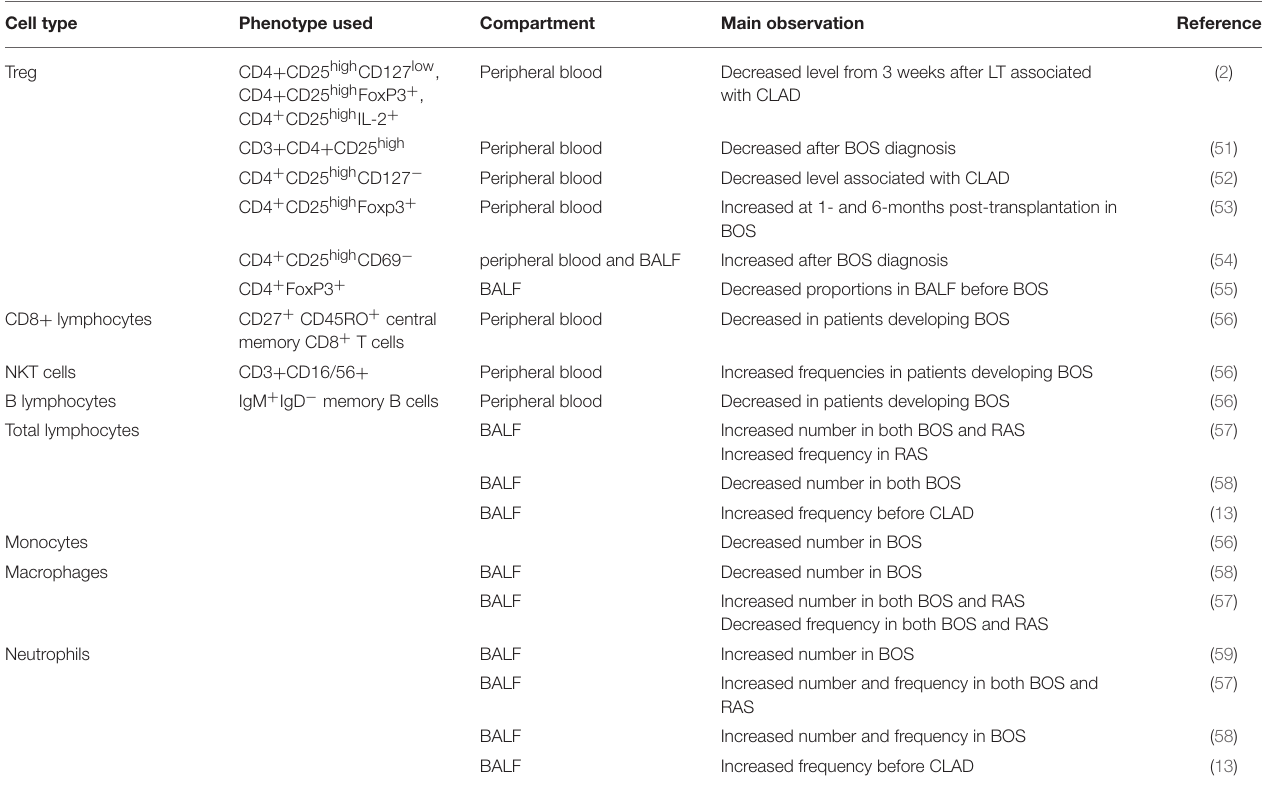
TABLE 1 | Immune cells proposed as CLAD